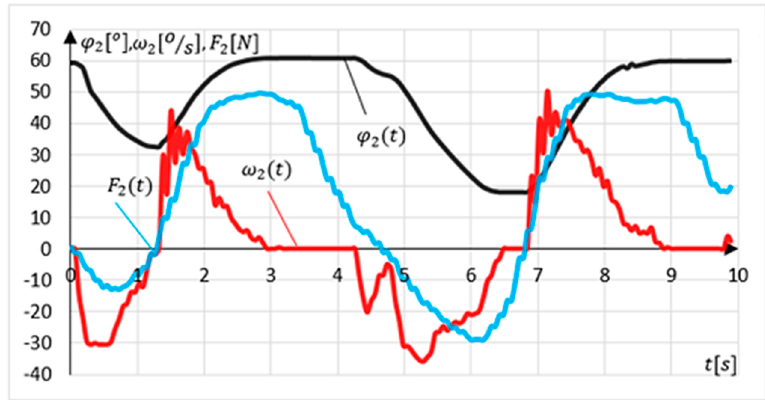
Figure 20. Results of MWR relapse procedure experiments.